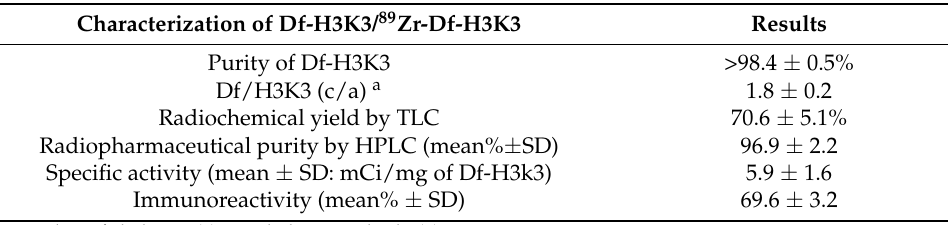
Table 1. Characterization of Df-H3K3 and 89 Zr-Df-H3K3 tracer ( n = 3).